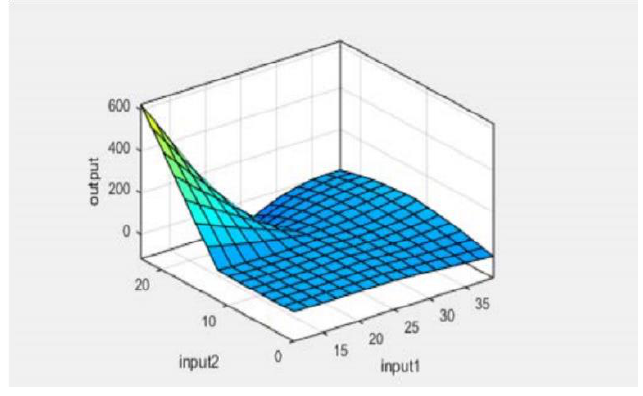
Figure 13. Surfview of output